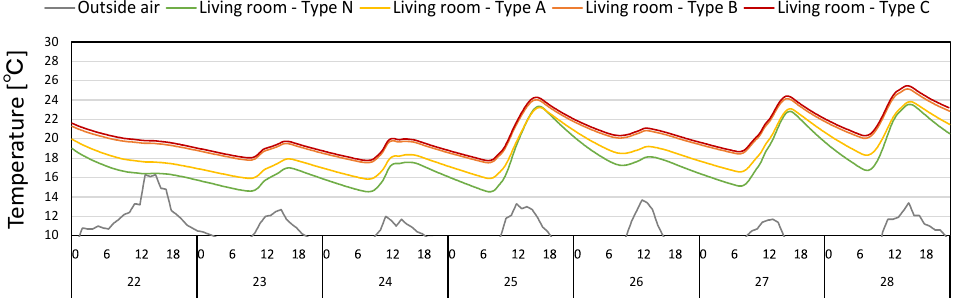
Figure 8. Comparison of ventilated roof-cavity temperature between Types N and A (February).